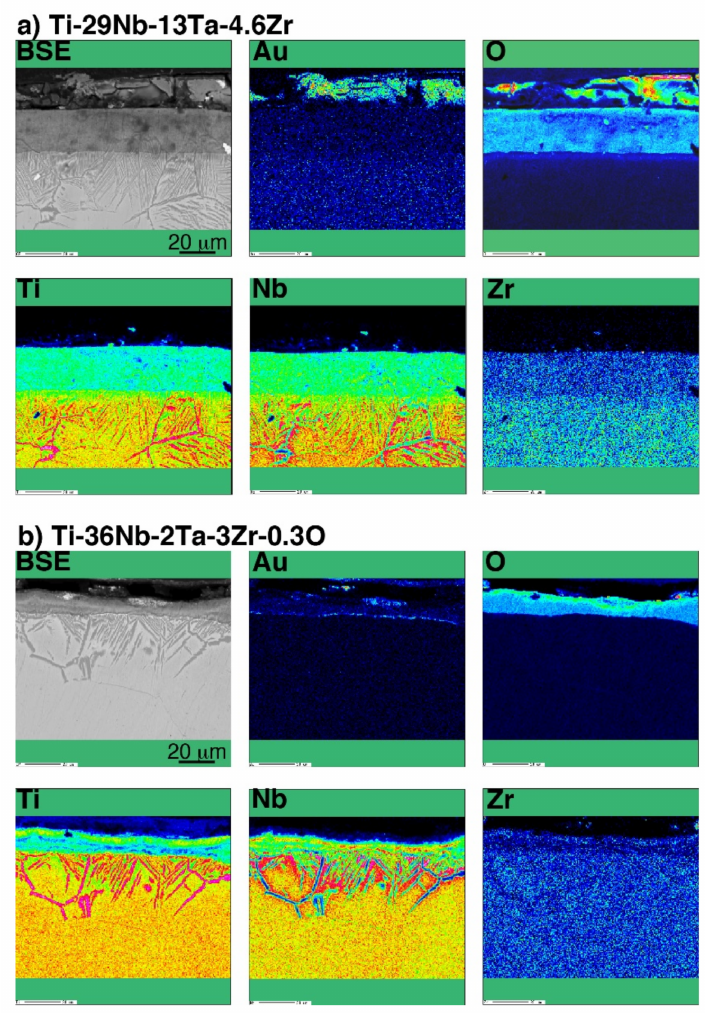
Figure 9. BSE image and chemical composition map of Au, O, Ti, Nb, and Zr in a cross-section of the interface of oxidized ( a ) Ti–29Nb–13Ta–4.6Zr and ( b ) Ti–36Nb–2Ta–3Zr–0.3O with Au marker